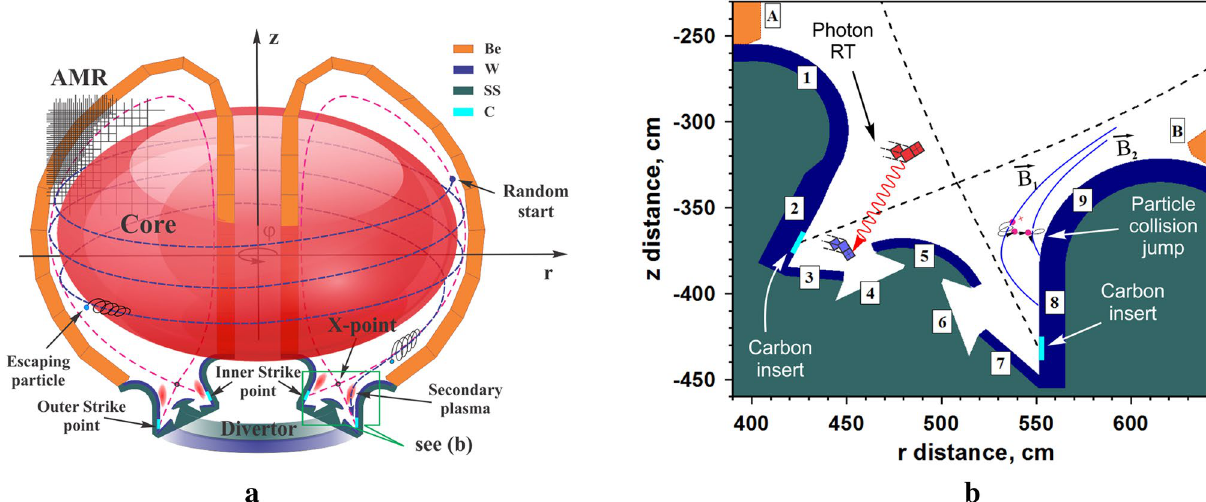
Figure 1. 3D schematic illustration of simulating ITER device: coordinate system orientation, adaptive mesh refining (AMR) for component surfaces, wall materials palette (Be, W, SS), escaping core particles into divertor area ( a ); divertor area cross-section showing carbon insert location, initiation of secondary plasma, scattering of DT plasma particles with change of magnetic field lines, photon radiation transport ( b ). The images were prepared using CorelDRAW Graphics Suite